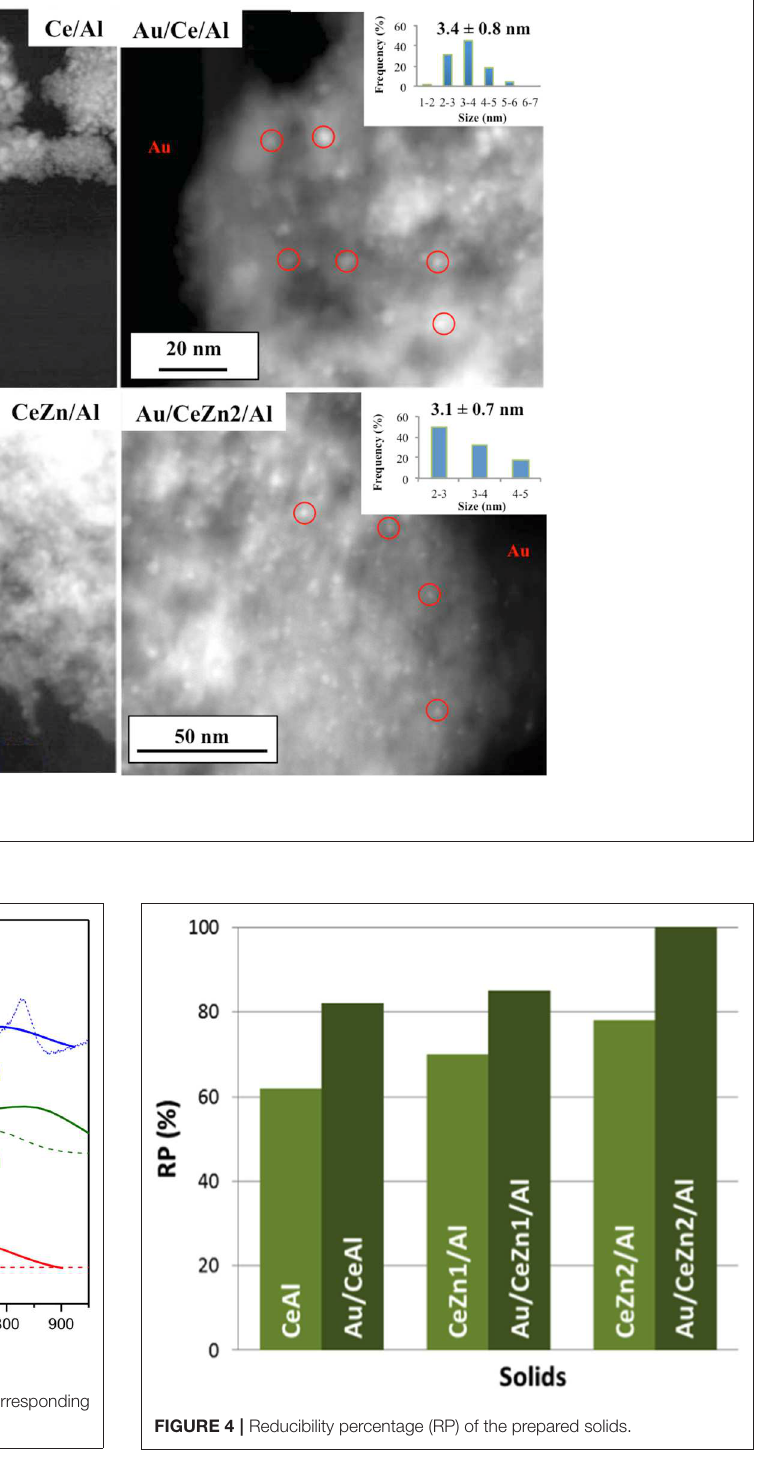
The quantification of the total reduction was made using Equation (4). The Reduction Percentage (RP) relates the experimentally measured H 2 consumption (E HC ) to the total